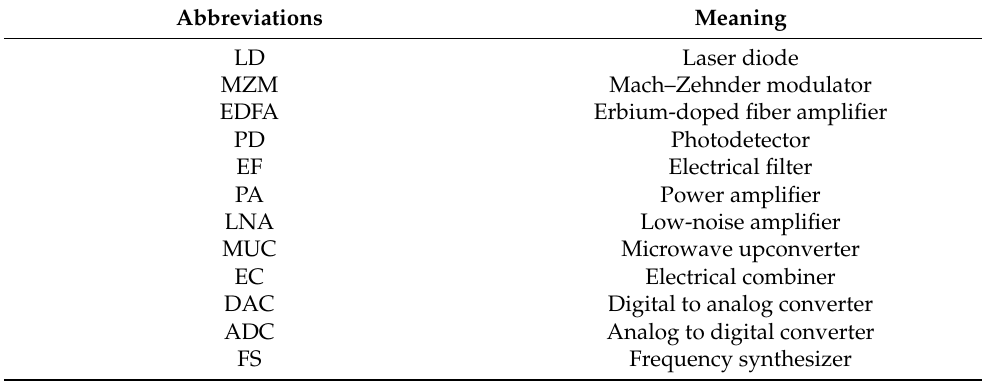
Figure 2. Schematic diagram of the optical spectrum under CS-DSB modulation, ( a ) for upconversion, ( c ) for downconversion, and the electrical spectrum after beating, ( b ) for upconversion, ( d ) for downconversion. Table 1. The meaning of the abbreviations in Figure